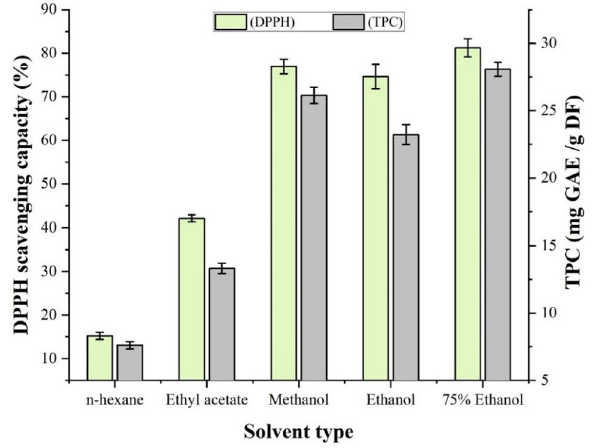
Figure 3. Effect of solvent on the antioxidant activity and TPC of fruits of Ficus auriculata. Data are presented as mean ± SD from triplicate